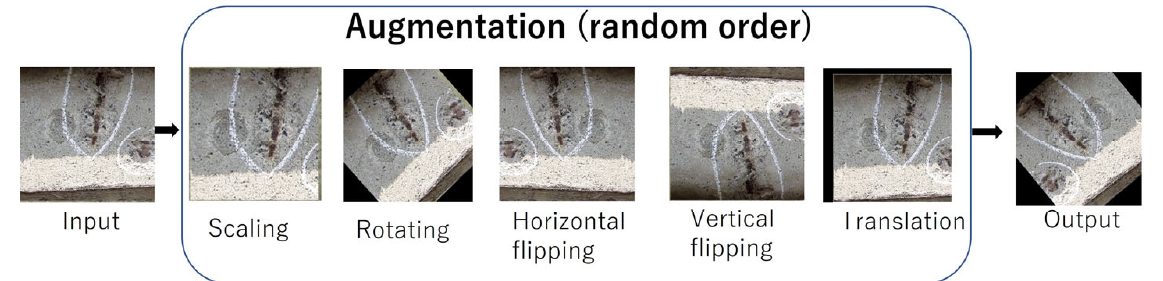
Figure 2. Example of augmentation.